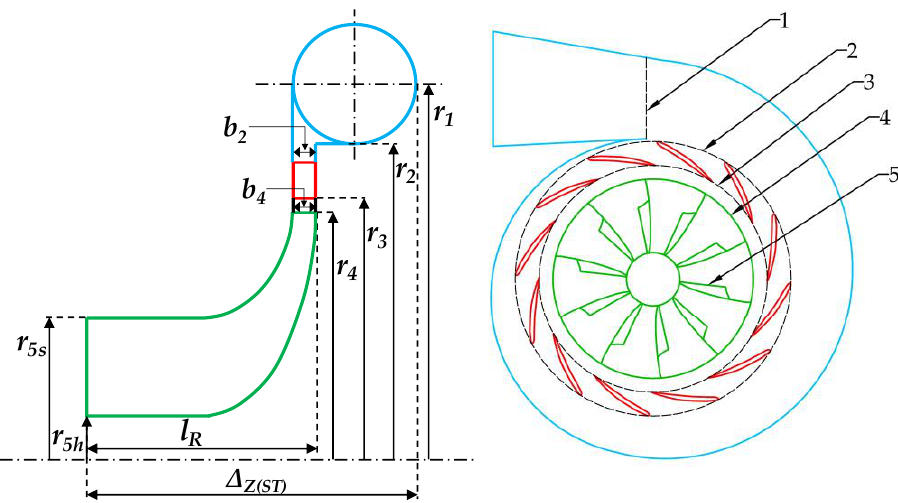
Figure 3. Schematic representation of turbine geometry, the numbers refer to the following main flow sections: (1) volute inlet; (2) nozzle inlet; (3) nozzle outlet; (4) rotor inlet; (5) rotor exit.